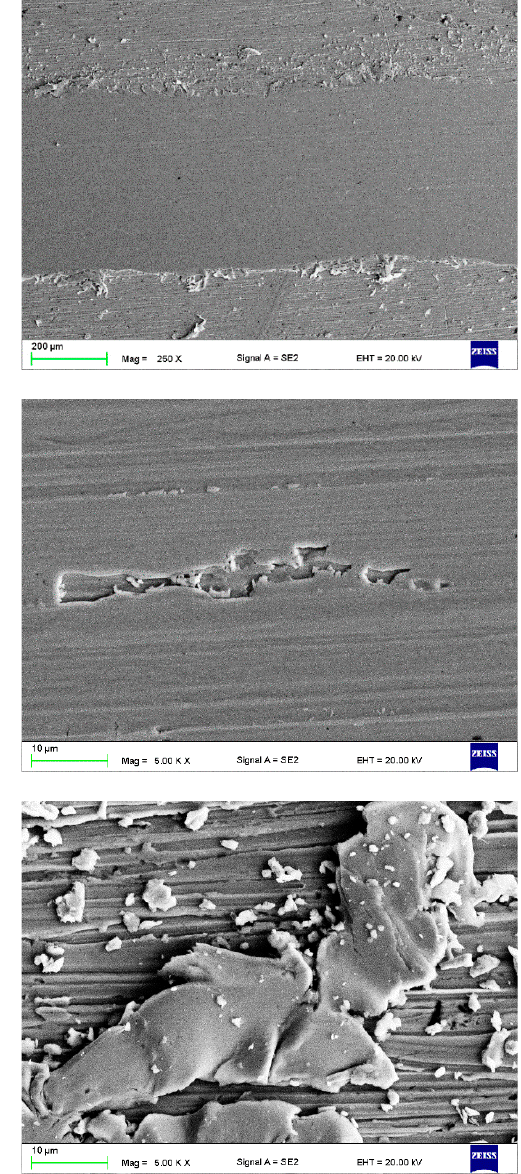
Figure 15. Wear track ( a , b ) of the tested Cu-ETP substrate and ( c ) wear debris. In the case of all CrAl layers, the edges of the wear track are